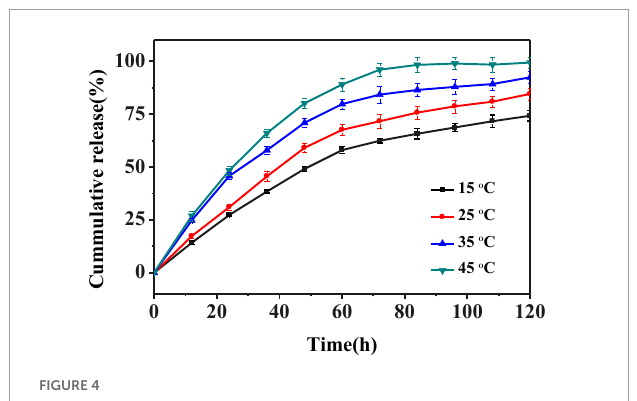
FIGURE5 Antioxidant of Perilla essential oil (PEO) and Perilla essential oil microcapsules (PEOM) [DPPH (A) and FRAP (B)